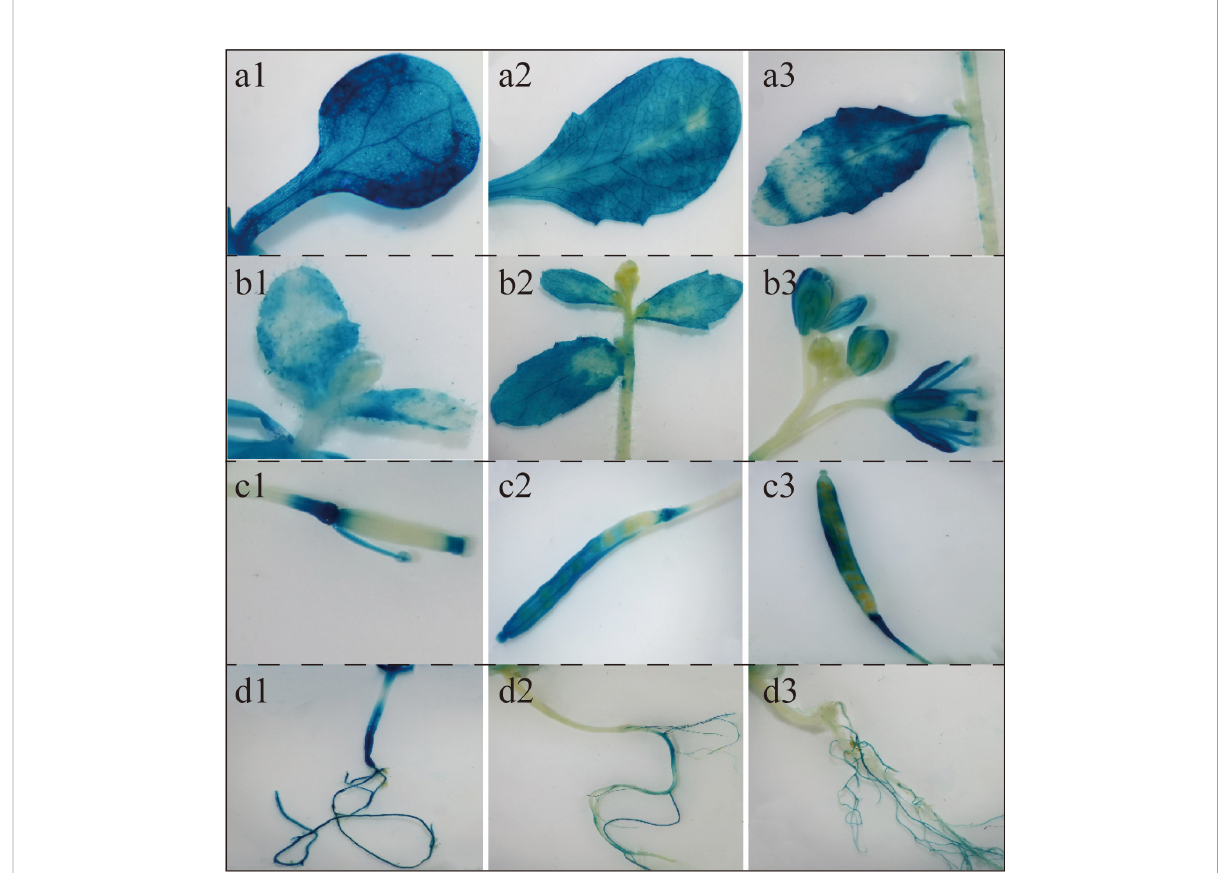
FIGURE 7 Localization of BcGRP23 expression at different stages using pBcGRP23::GUS for b -glucuronidase (GUS) staining. a1 – a3 , cotyledons, rosette leaves, and cauline leaves; b1 – b3 , fl owers, leaves, and stems in the bolting, bud, and fl owering stages; c1 – c3 , pods in the pod setting, seed expansion, and seed maturity stages; d1 – d3 , roots in the bolting, fl owering, and fruiting